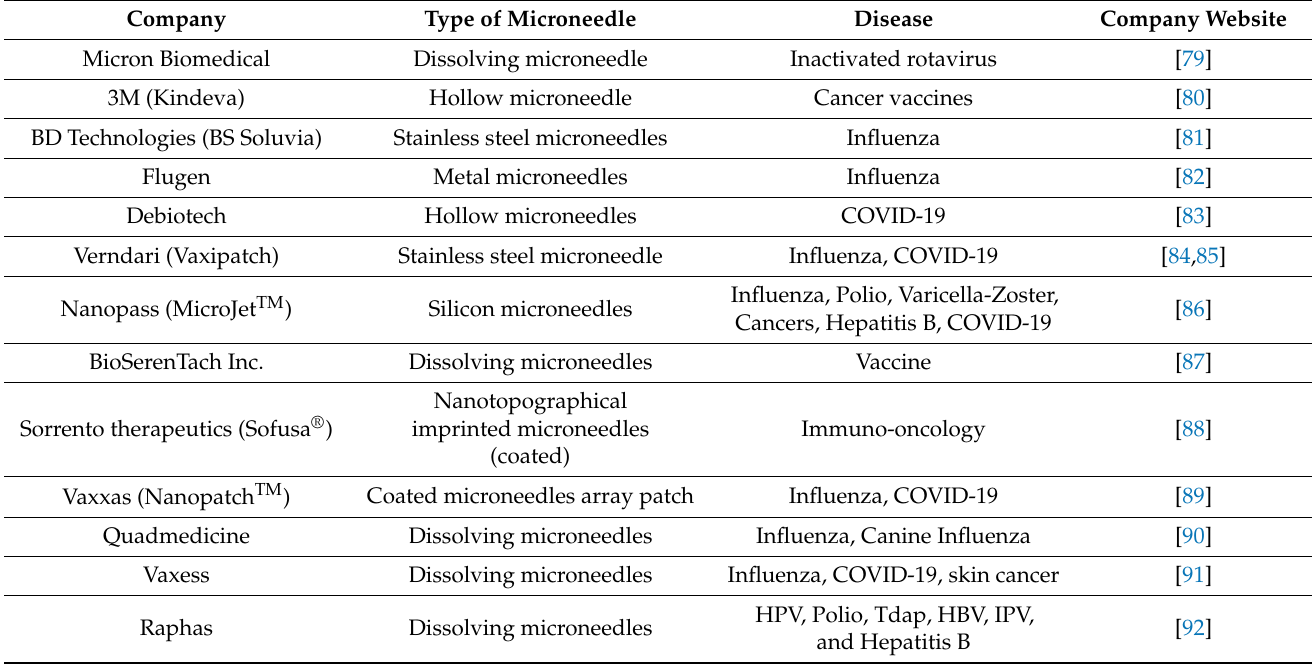
Table 2. Companies developing microneedles for vaccine